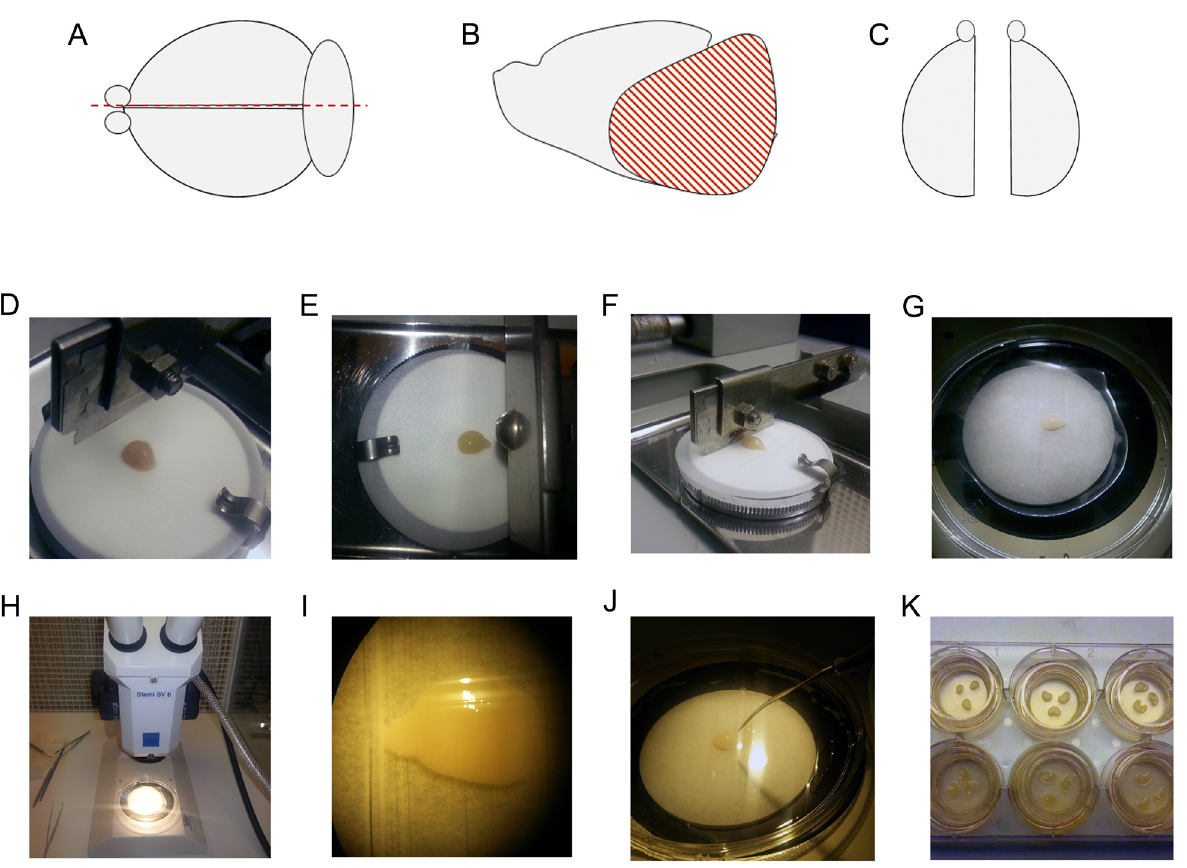
Figure 1. Preparation of organotypic brain slice cultures. ( A ) After removal from the skull, brains are bisected along the midline using a razor blade. ( B ) The thalamus, cerebellum and brain stem are removed using the hippocampal dissection tool leaving the cortex, hippocampus and connected brain regions. ( C ) Two hemi-brains are kept in oxygenated dissection buffer throughout the procedure; one hemi-brain is stored whilst the other is processed. ( D ) A hemi-brain is placed on dampened filter paper on the cutting surface of a McIlwain tissue chopper. ( E – F ) 350 µm coronal slices are cut. ( G – J ) Slice cultures are sequentially separated under a dissection microscope using a hippocampal dissection tool. ( K ) Three slices are plated per well on Millipore membrane inserts in 6 well plates. Three consecutive slices can be